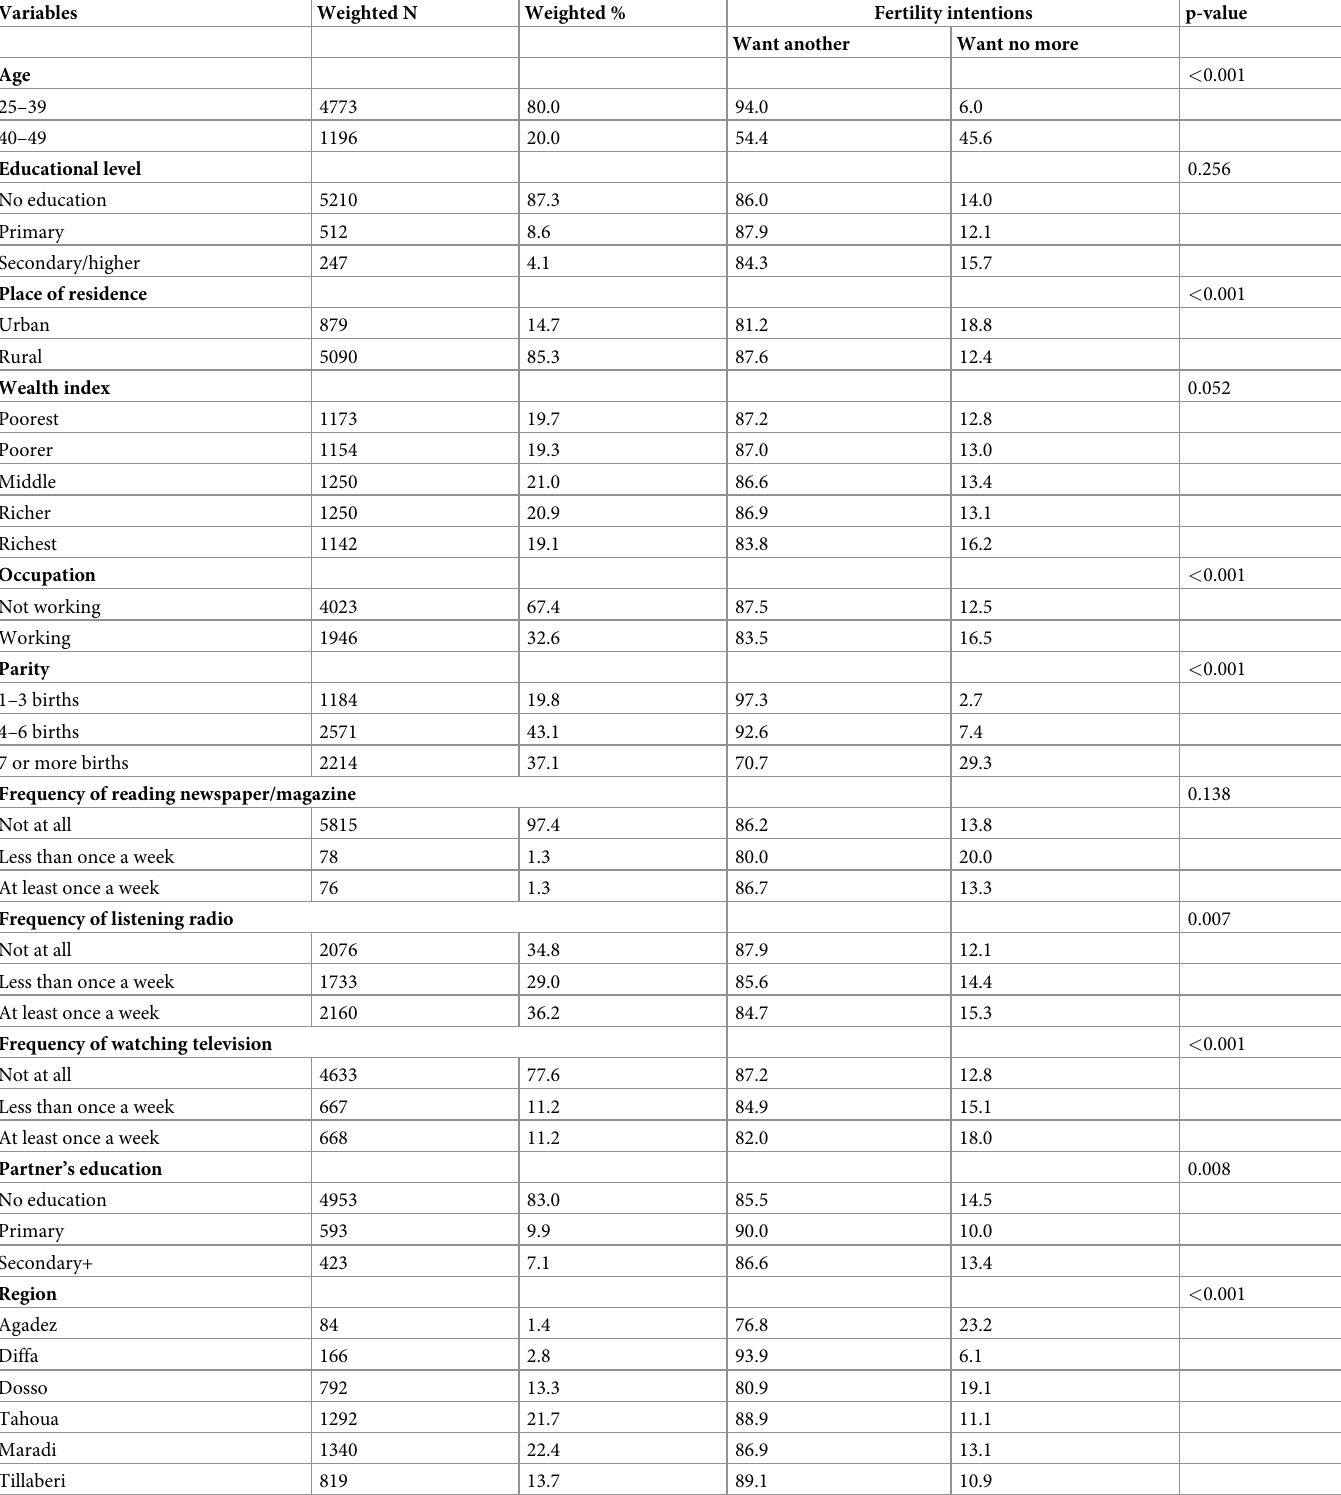
Table 1. Distribution of fertility intentions across socio-demographic characteristics of childbearing women in Niger (weighted).